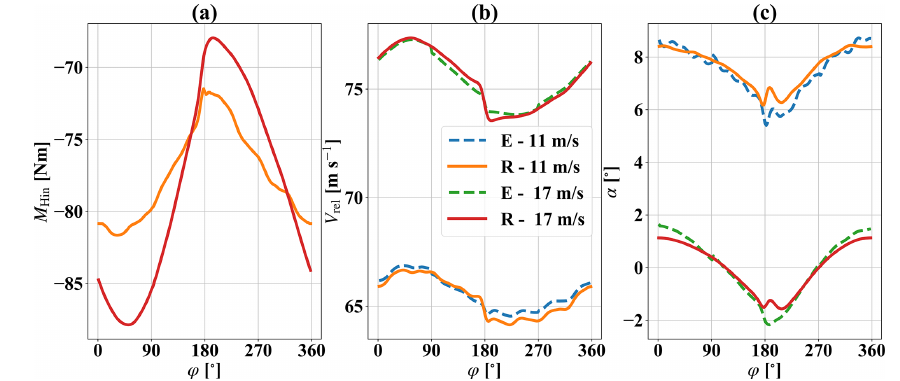
Figure 5. Behavior of the estimator for two different wind speeds as a function of the rotor azimuth angle. (a) Flap hinge moment; (b) relative velocity; (c) angle of attack. E: estimated; R: